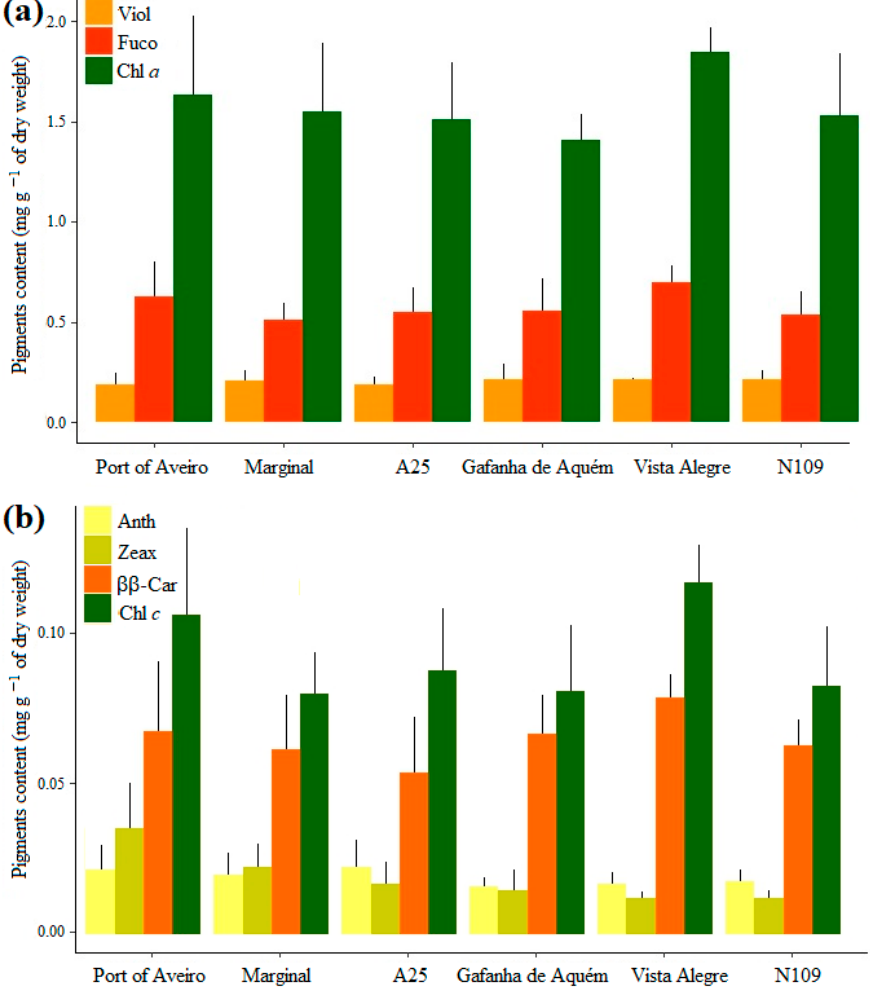
Figure 5. Concentration of photosynthetic pigments of Fucus vesiculosus (mg g − 1 of dry weight; mean + standard deviation; n = 5) at the six locations from the inlet of Ria de Aveiro and along the Ílhavo Channel, Portugal. ( a ): The most abundant pigments, violaxanthin (Viol), fucoxanthin (Fuco) and chlorophyll a (Chl a ); and ( b ): the less abundant pigments, antheraxanthin (Anth), zeaxanthin (Zeax), chlorophyll c (Chl c ) and β , β -carotene ( ββ -Car).